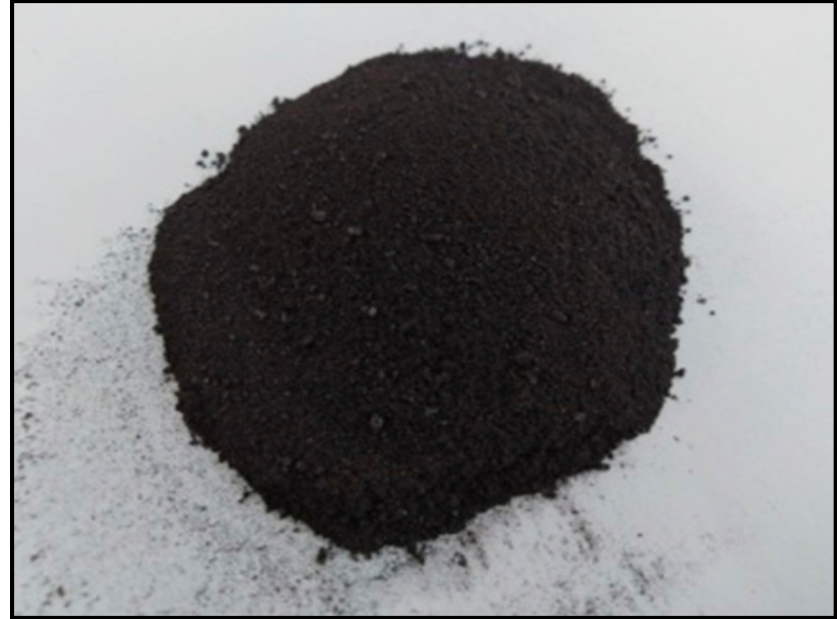
Figure 2. The final appearance of the catalyst.